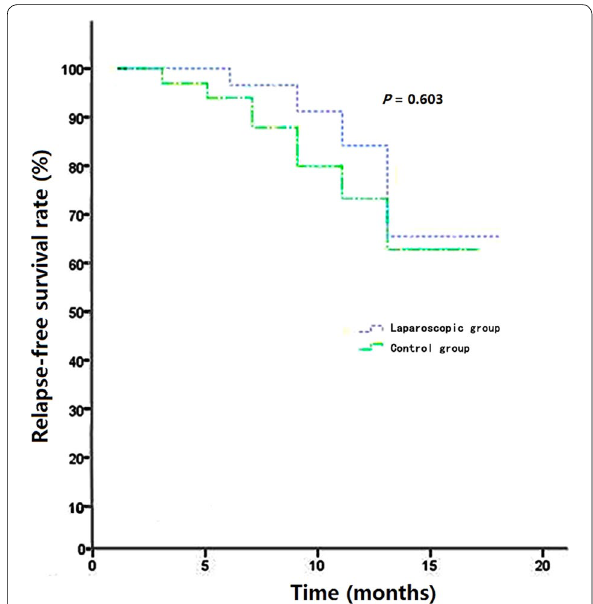
Fig. 1 Kaplan–Meier curves showing relapse‑free survival (RFS) for all 64 patients with hepatocellular carcinoma. No significant difference in RFS was observed between the laparoscopic group and the open surgery (control)